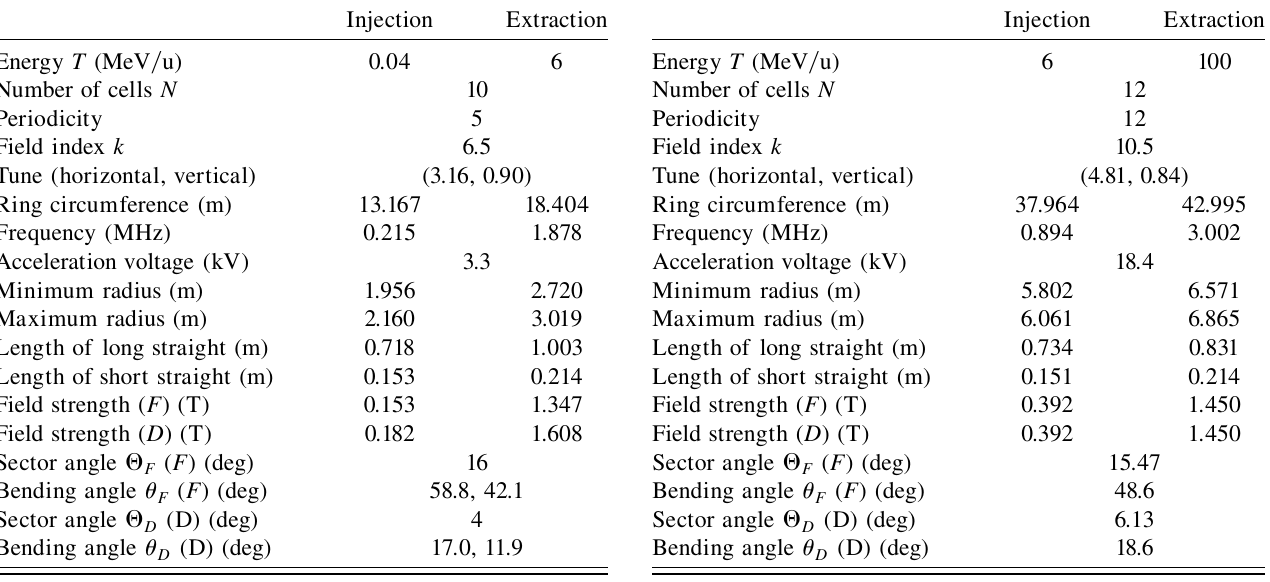
(cid:7) k , g=g (cid:5) (cid:6) R=R 0 0